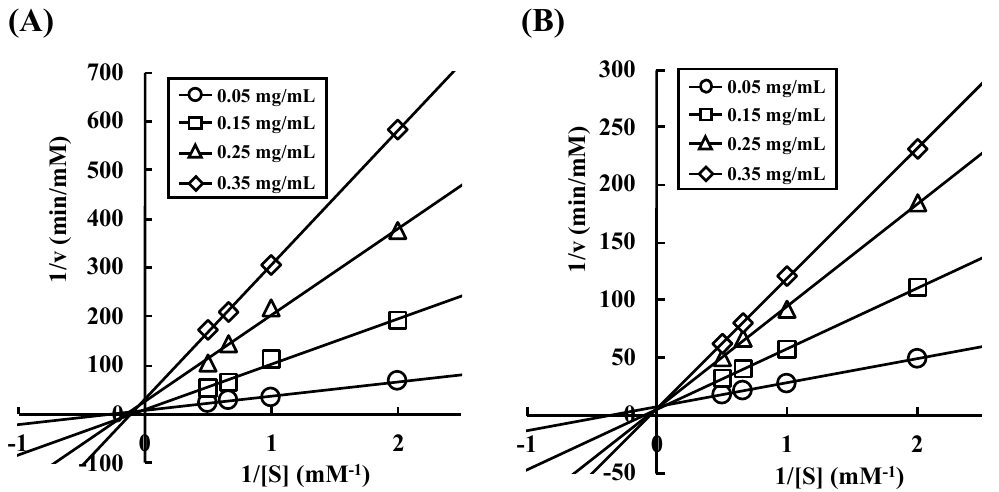
Figure 8. Kinetic analysis of the inhibitory activity against α -amylase from porcine pancreas. ( A ) Wheat α -AI; and, ( B ) Buckwheat α -AI.